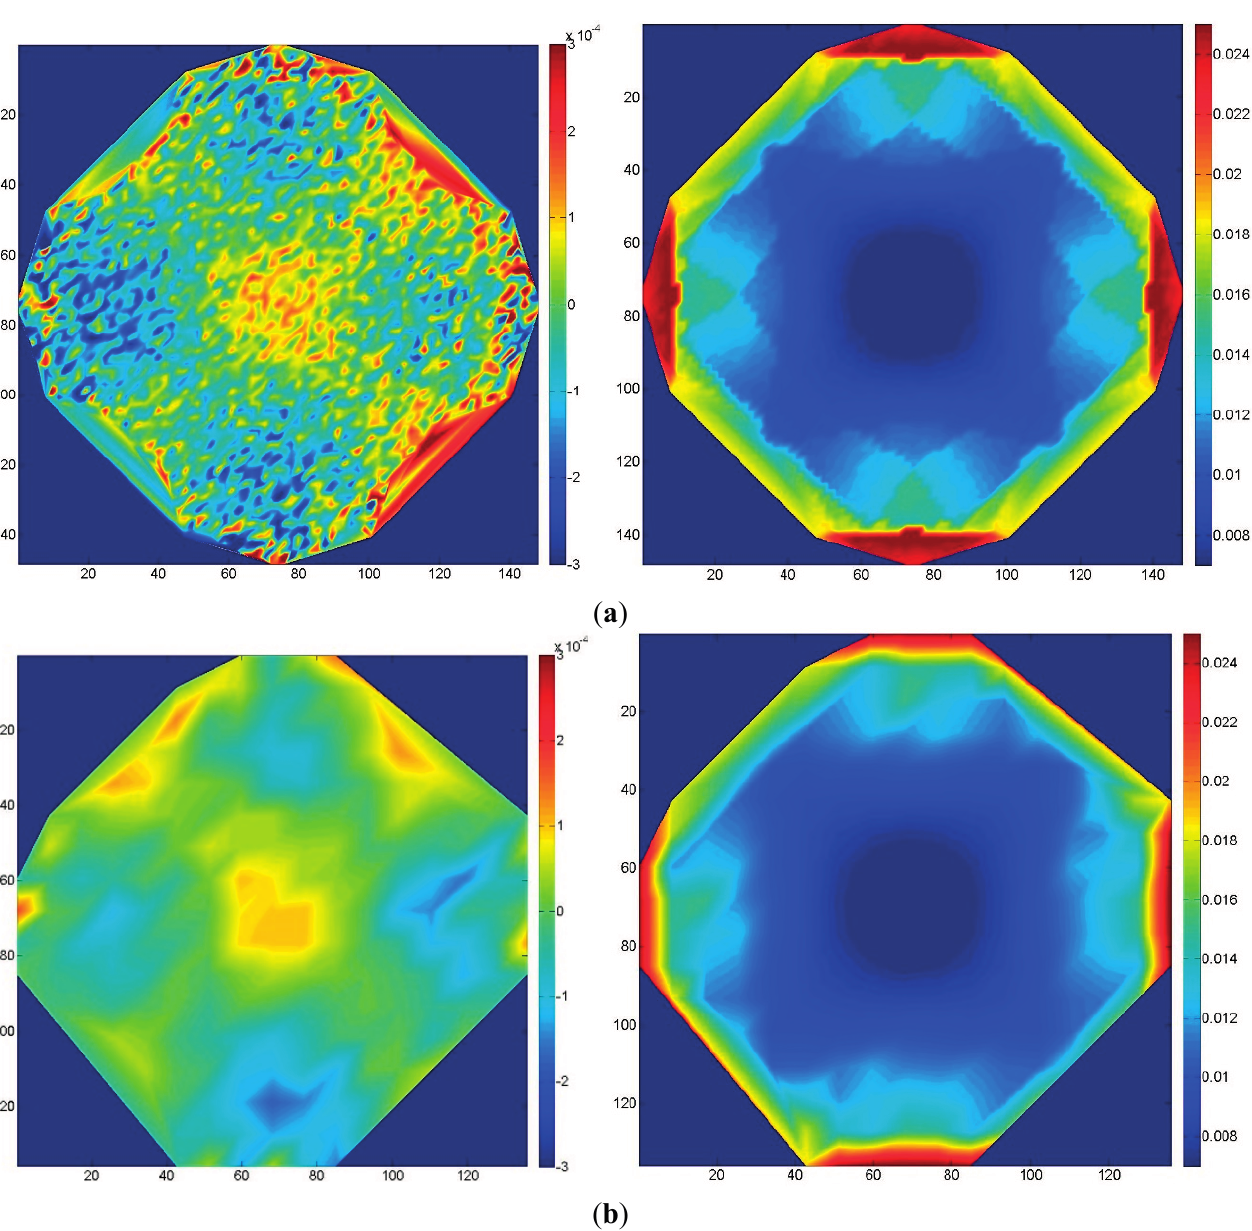
Figure 12. Case 5: errors due to using a varying number of tie points. Left column: mean error; right column: standard deviation of the error. ( a ) 10,000 tie points; ( b ) 500 tie